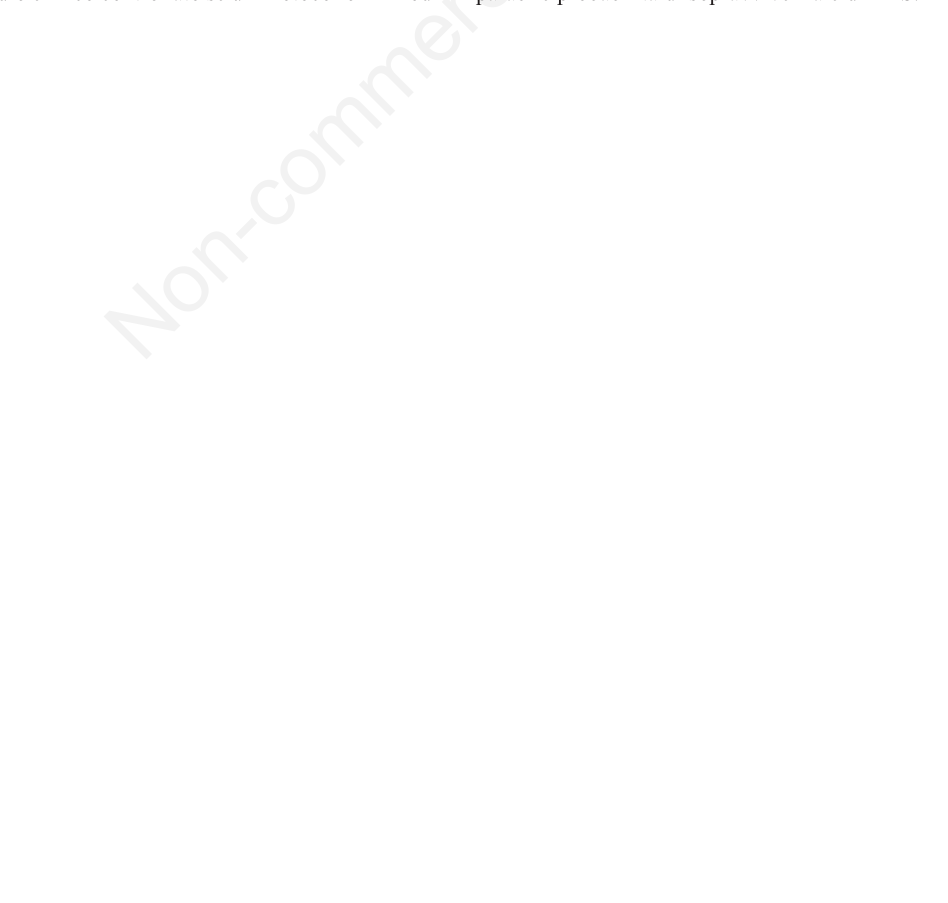
Protocollo II o con un doppio Protocollo III hanno com- parabile probabilità di sopravvivenza e di